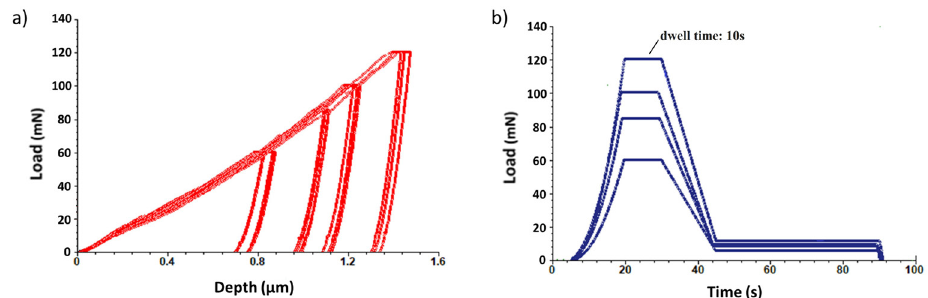
Figure 7. Load-displacement curves obtained from nanoindentation measurements on oxidized sample: a) Load-displacement curves; b) dwell time at maximum applied load.